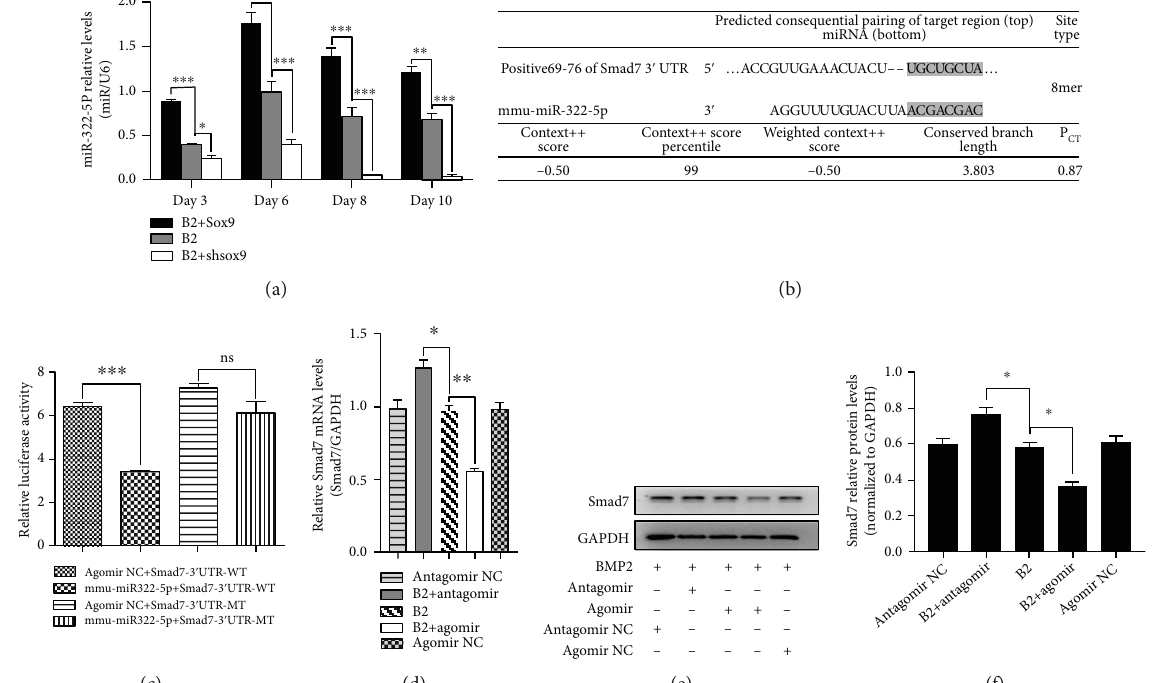
8merSite typePredicted consequential pairing of target region (top)